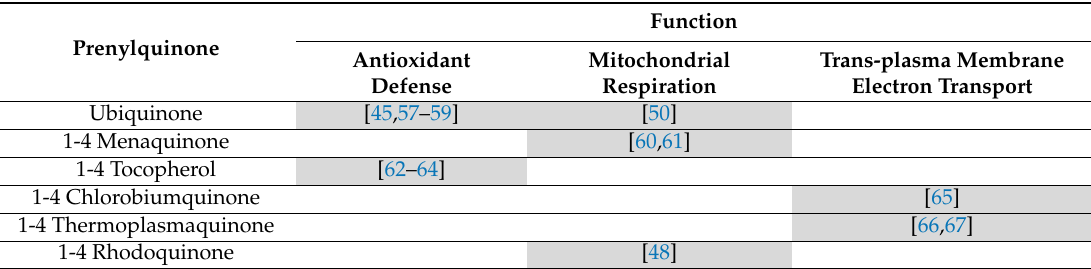
Table 1. The table indicates the parasitic prenylquinone functions among protozoa. For more information, check the reference section. Grey squares contain examples of previously characterized prenylquinones from protozoa. White squares indicate still non-characterized prenylquinones.